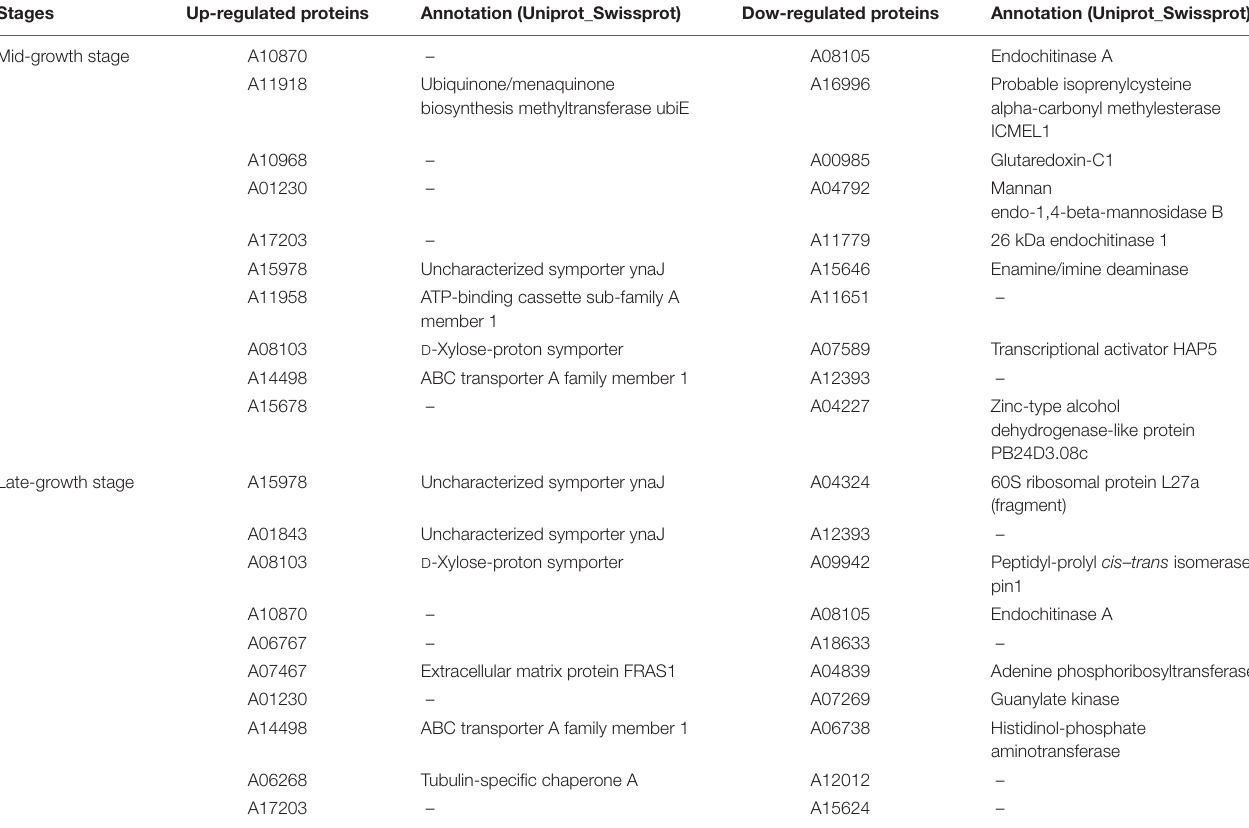
TABLE 4 | The top 10 up-/down-regulated proteins of anaerobic fungus Pecoramyces sp. F1 at mid- and late-growth stages.